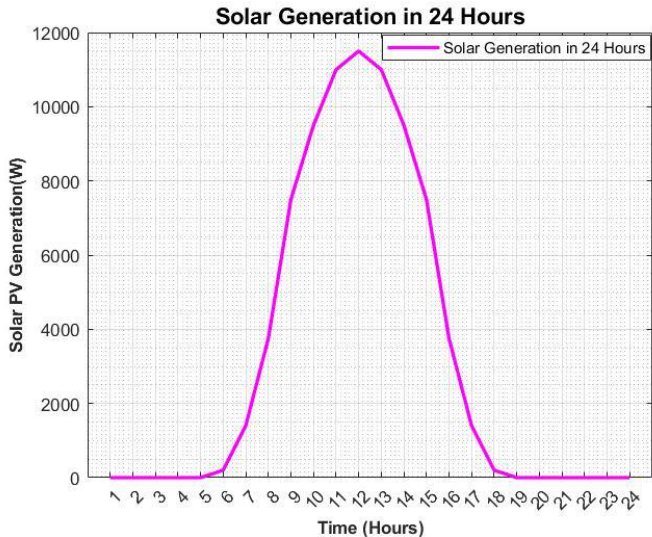
Figure 9. Solar power for the entire day.